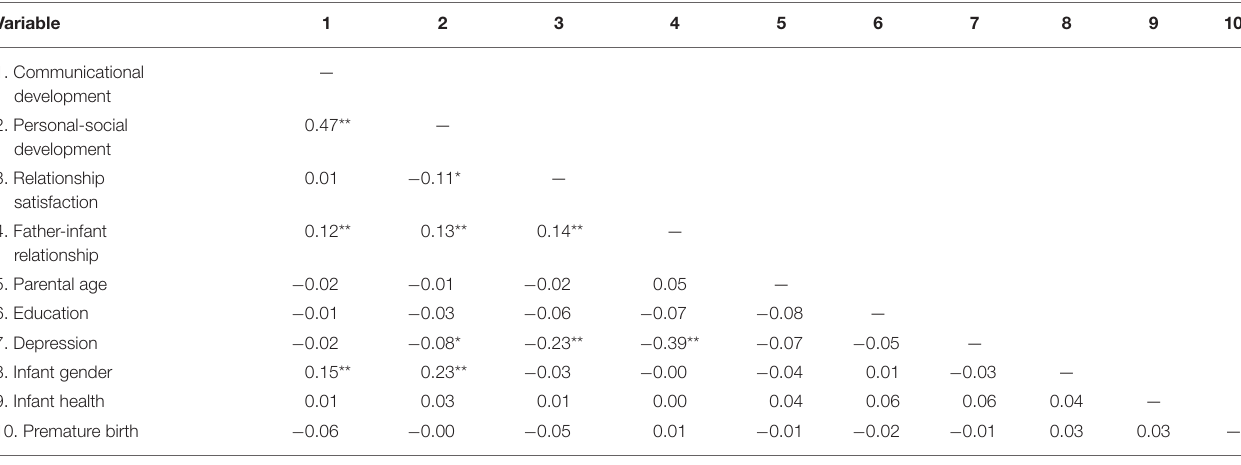
TABLE 3 | Pearson correlation coefficients ( r ) of predictors, control variables, and outcomes for fathers. Variable